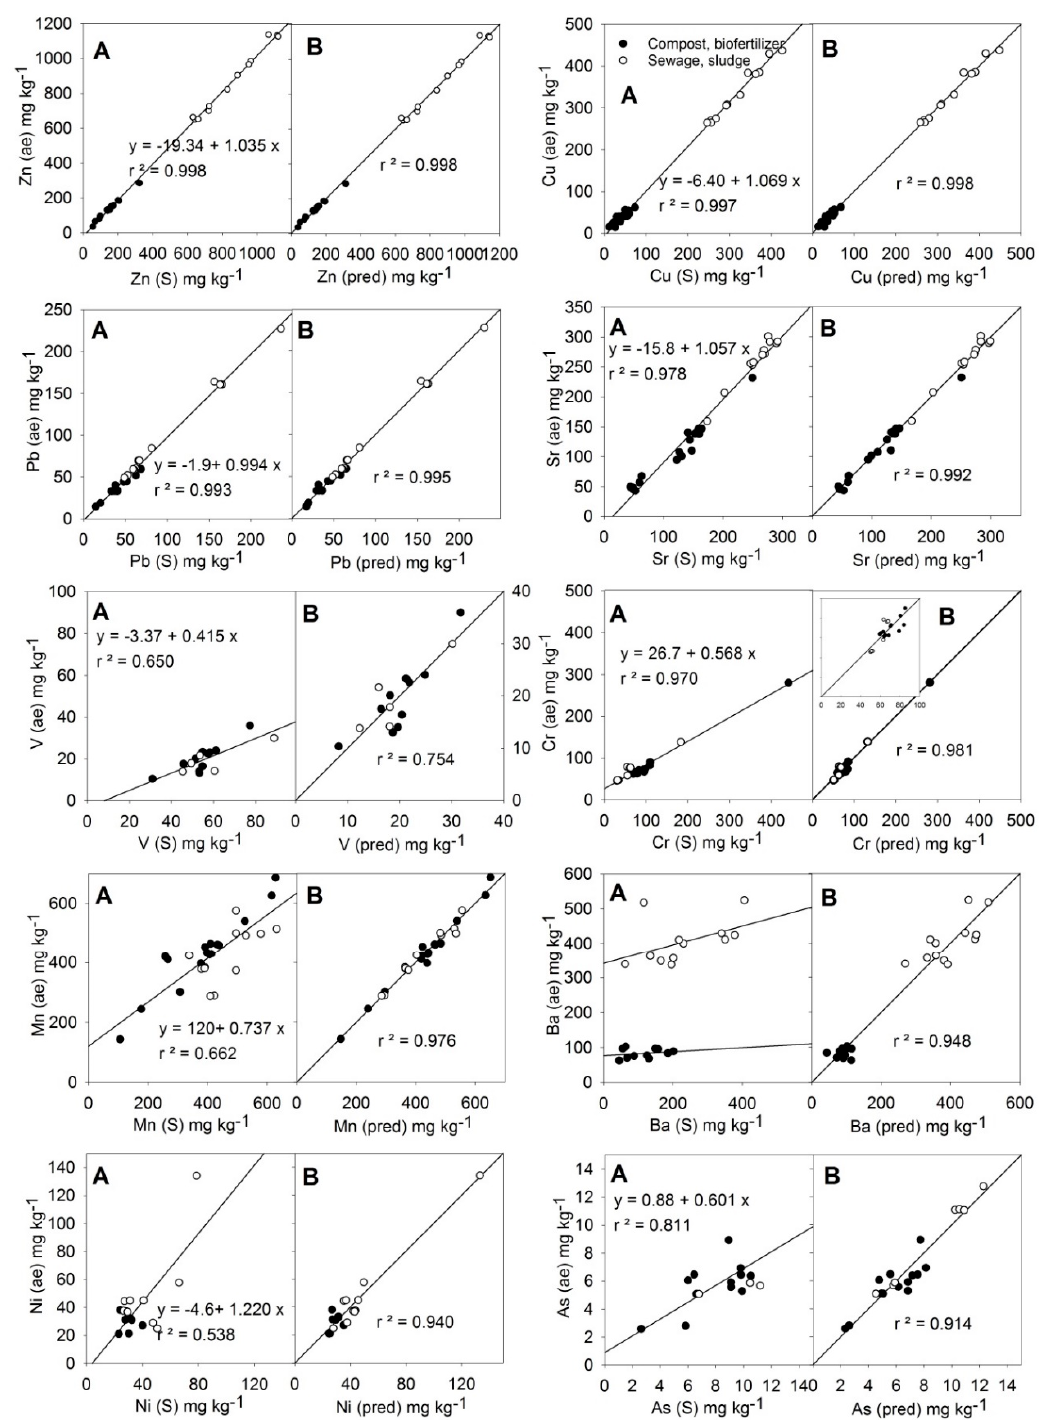
elements. 4 N, number of data points. ns no significative.